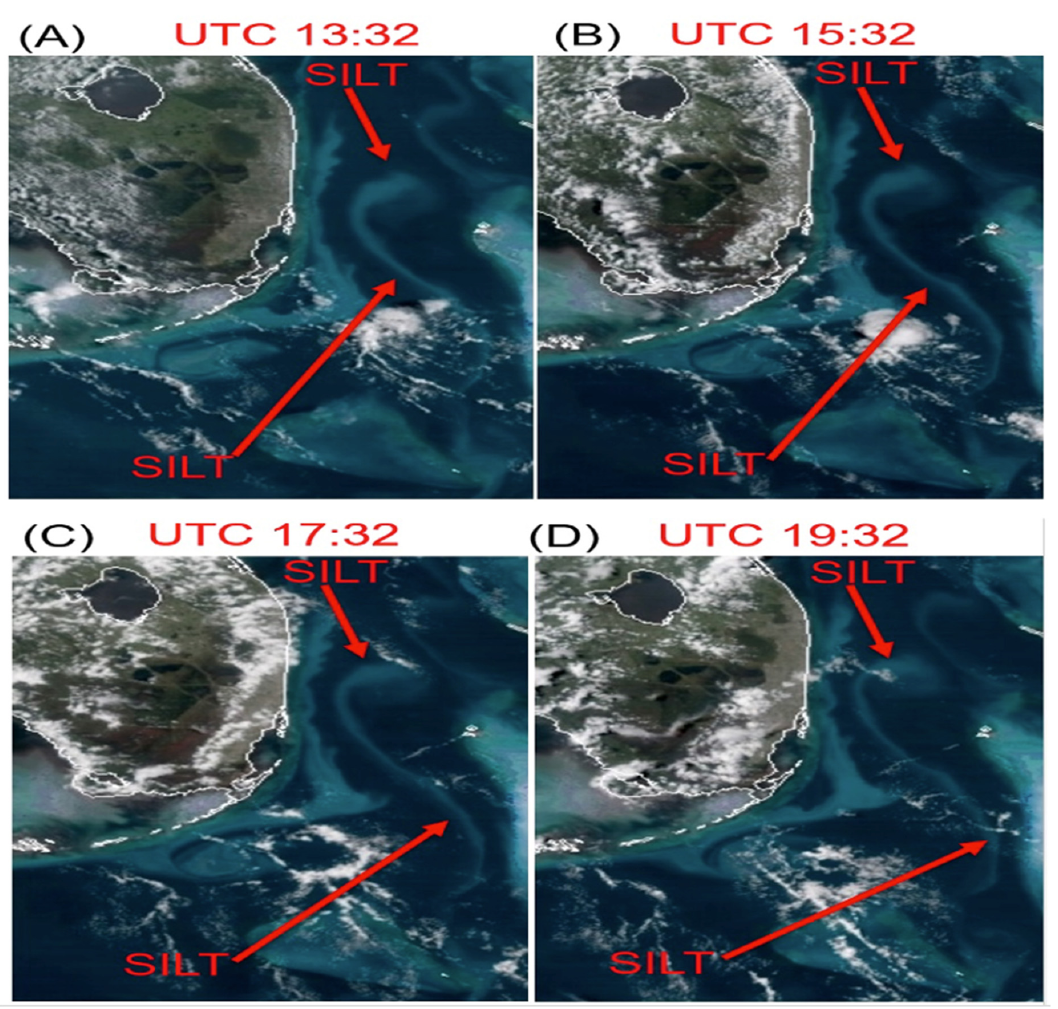
Figure 1A–D are false color images (Red: 0.64 µ m; Green: 0.865 µ m, Blue: 0.47 µ m) acquired at UTC 1332, 1532, 1732, and 1932, respectively, on September 14, 2017 over the coastal areas of Florida. The silt stirred up by Hurricane Irma was captured in the Gulf Stream and advected northward while spinning o ff eddies. The original movie images at a time interval of five minutes can be found from http: // rammb.cira.colostate.edu / ramsdis / online / loop_of_the_day / for the day of 2017 / 09 / 14. Remote Sens. 2020 , 12 , x FOR PEER REVIEW